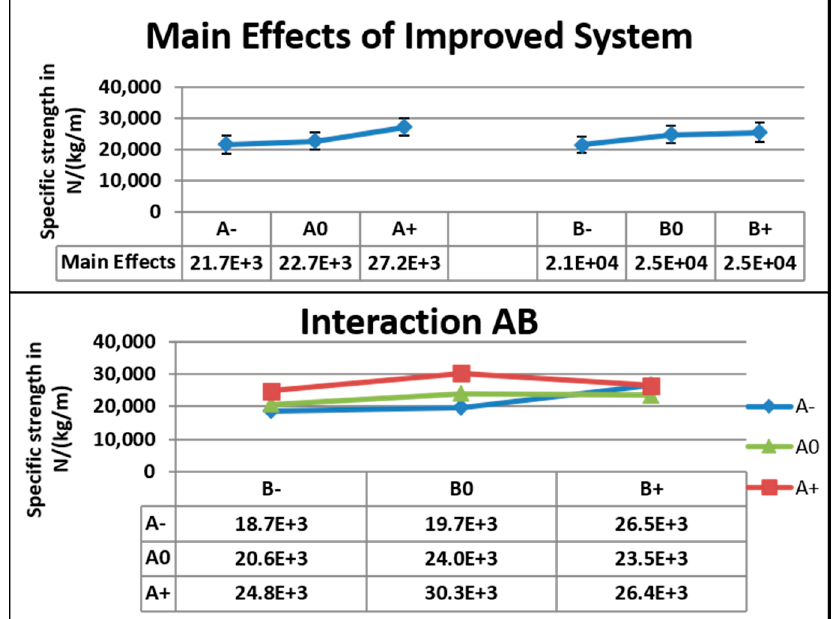
Figure 13. Main effects, standard deviation, and interactions for the tensile data of the improved system.